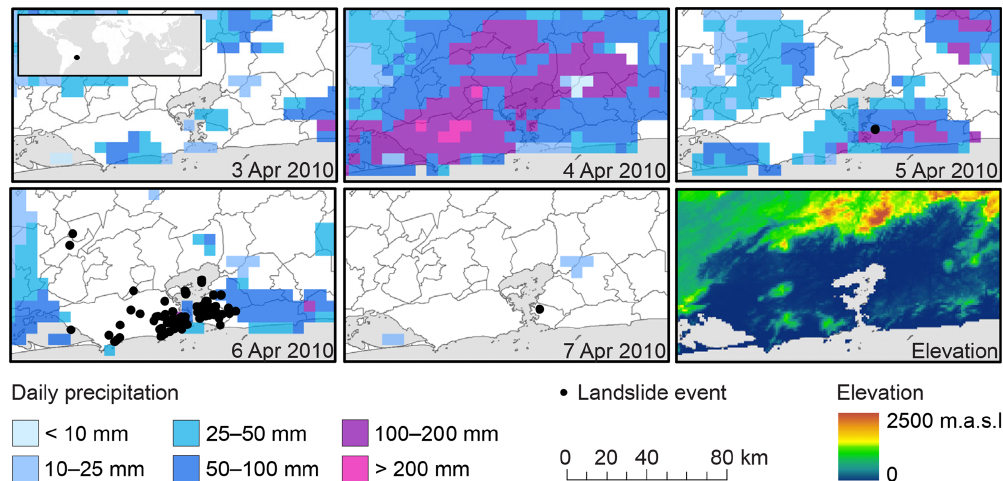
Figure 7. Location of the events in the cluster with the most events per day located in Rio de Janeiro, Brazil. Also shown are daily precipitation and elevation. Elevation data are taken from the US Geological Survey